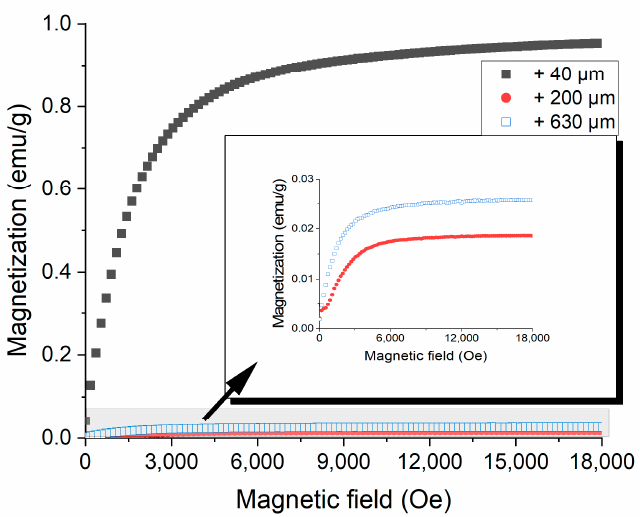
Figure 9. Magnetization curves and saturation induction for different quartz sand particle sizes. The obtained data shows that the smallest particles (below 40 µm) possess the largest magnetization of 0.923 emu/g. The intermediate particles have the smallest magnetization of 0.018 emu/g. The spontaneous magnetization increases again for the larger particle sizes, up to 0.025 emu/g. The evolution of the magnetization follows the phase evolution recorded by XRD; lower particle sizes contain a high amount of metallic Fe or iron oxides (with higher magnetization) evenly dispersed in the sand mass. At higher particle size ranges, the particle magnetization is lower, since iron phases are diluted in larger SiO 2 particles, as recorded by SEM/EDX. If we recall the Figure 5 image, as the iron phases seem to be mechanically blocked in the SiO 2 particles, size reduction by further grinding can help the iron removal by magnetic separation. If the magnetization is higher, lower magnetic field values are required for separation. However, for the 200–400 µ m particle size, magnetization exhibits different behaviors, and a hysteresis loop was recorded, as presented in Figure 10.